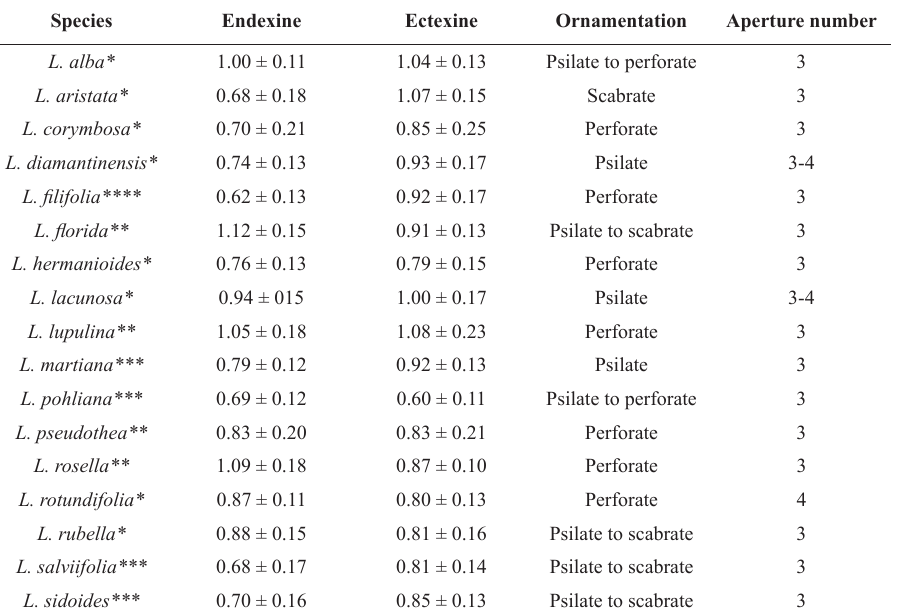
Pollen morphological data (mean values and standard deviation in μm) of Lippia